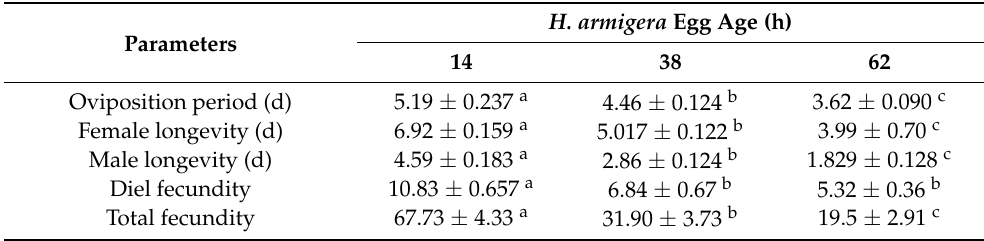
Table 2. Mean ( ± SE) oviposition period, female and male longevity (d), and diel and total fecundity of T. euproctidis reared from H. armigera eggs of different ages.